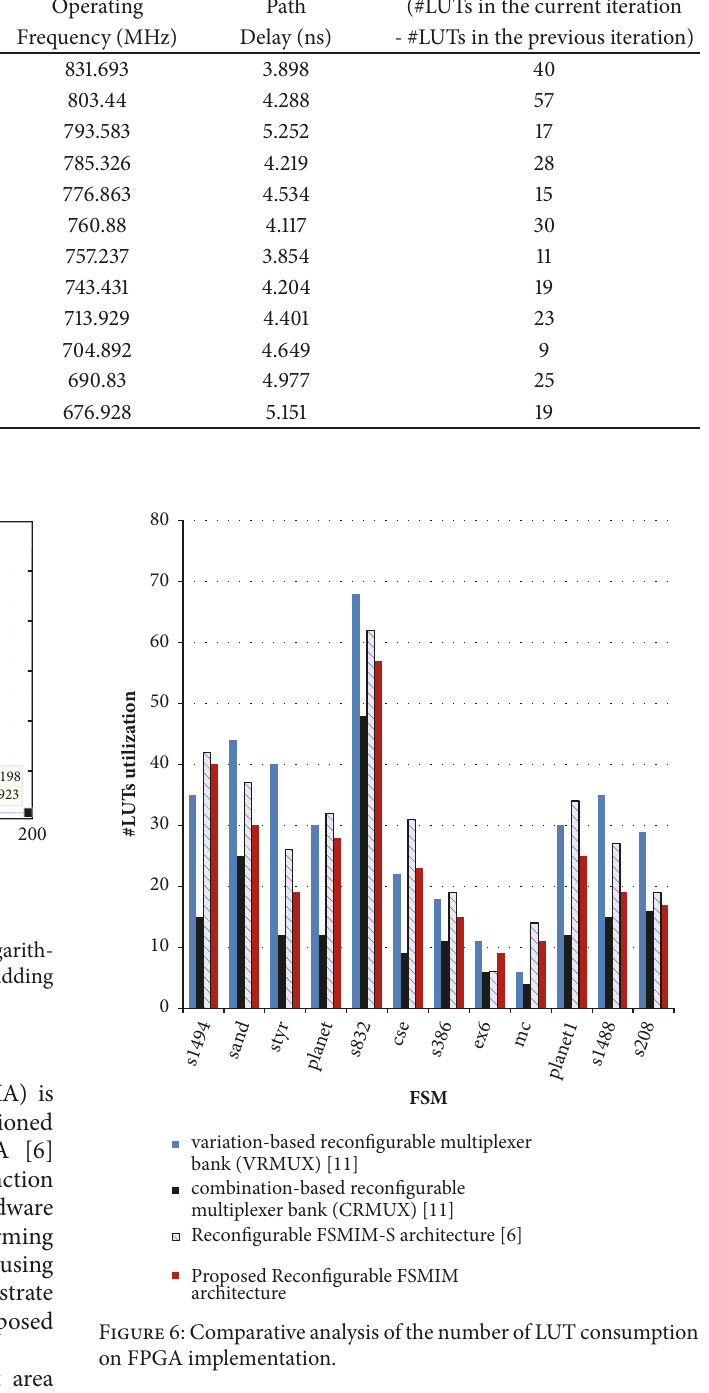
speed improvement by an average of 11.06% is obtained. The proposed architecture requires an average of 58.38% more LUTs as compared with CRMUX [11] during FPGA implementation. It is the only trade-off for the proposed